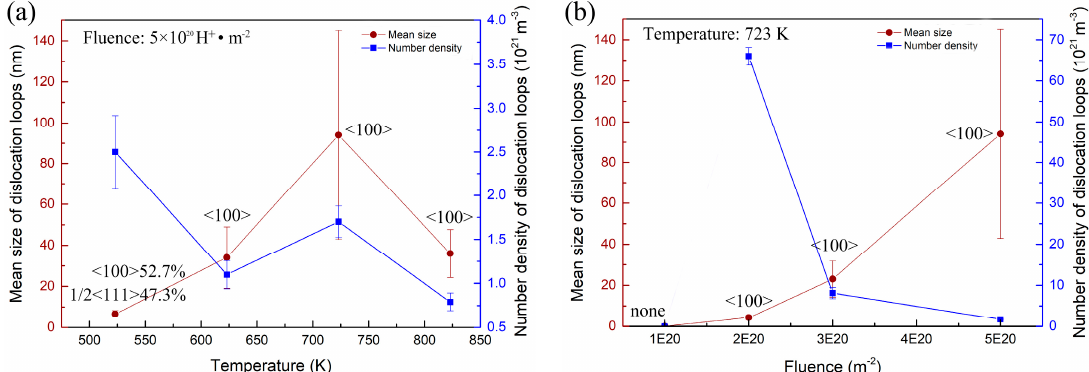
Figure 6. Mean sizes and densities of dislocation loops dependent on irradiation ( a ) temperature and ( b ) fluence. The meaning of the vertical lines is standard deviation.